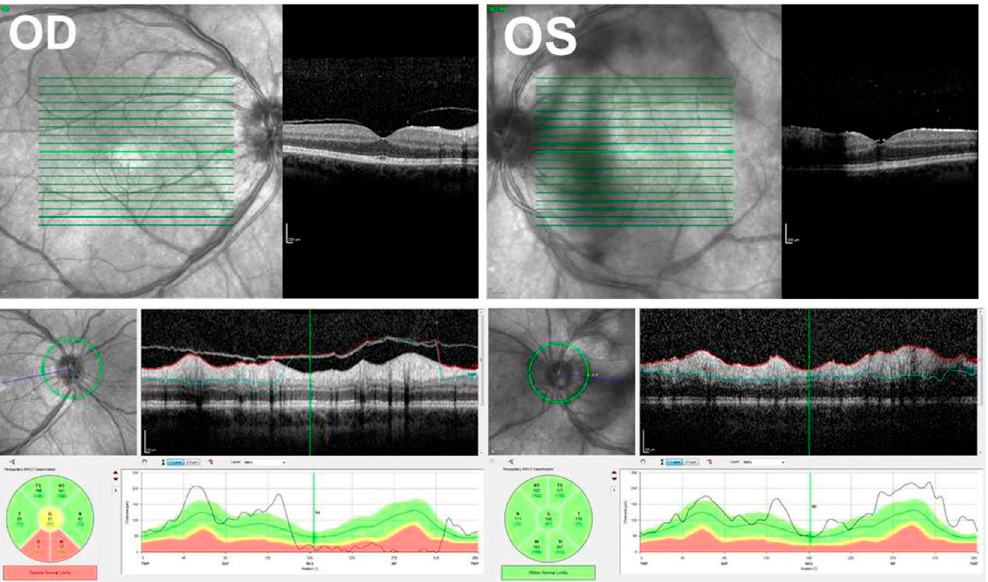
Figure 15. Swept-source OCT of the same patient with birdshot chorioretinopathy shown in Figure 14. Retina: B-scan shows retinal changes. There are intraretinal cysts and hyperreflective foci in outer layers. Optic nerve of the right eye shows reduced nerve fiber layer.